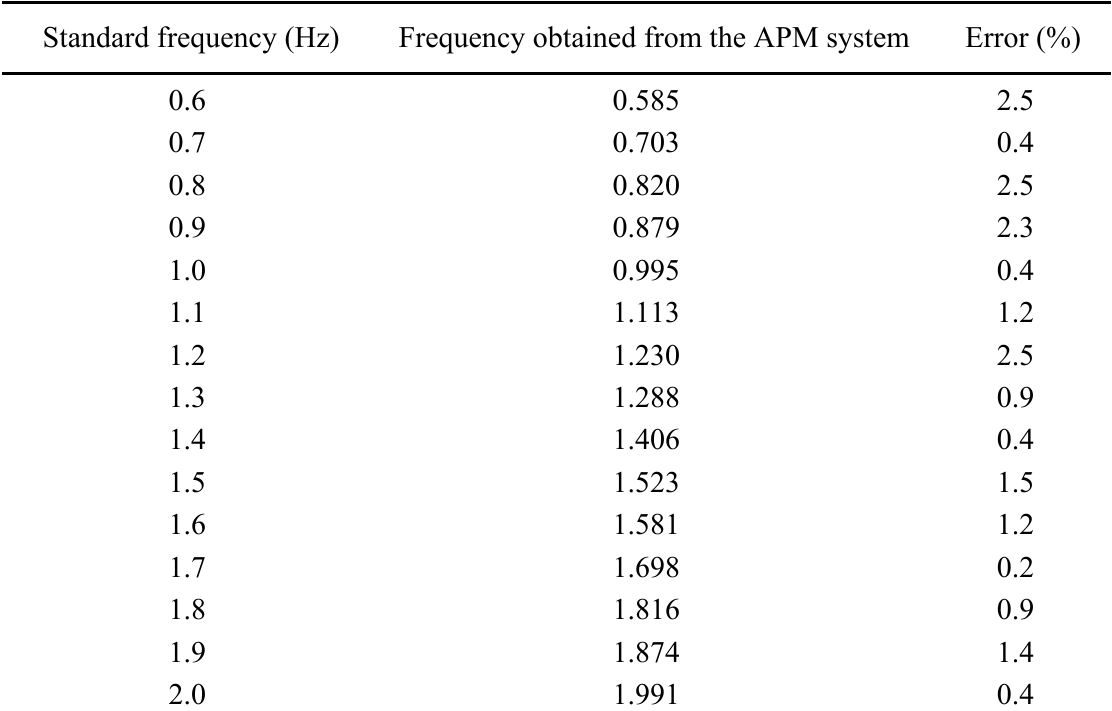
Table 1. Frequency calibration of the APM system from 0.6 − 2.0 Hz with a function generator and a